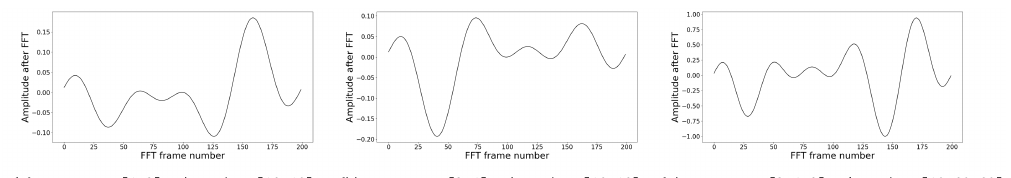
Figure 6. A comparison of behavioral spectra in different sequences ( a ) activity 1 finished before activity 2 started. Each performance duration was 10 min; ( b ) activity 2 finished before activity 1 started. Each performance duration was 10 min; ( c ) activity 1 performed between activity 2. The durations were 10, 60, and 60 min respectively.